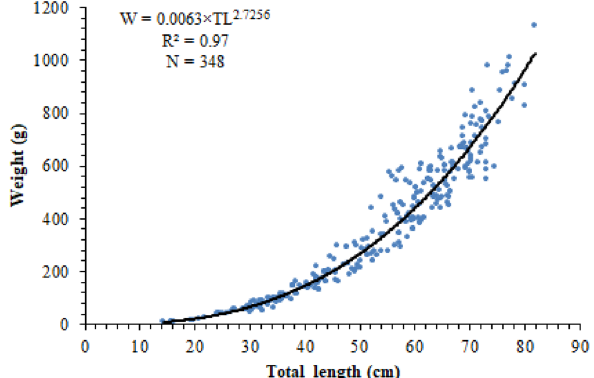
Figure 4. Length–weight relation of M. mastacembelus population inhabiting Keban Dam Lake.